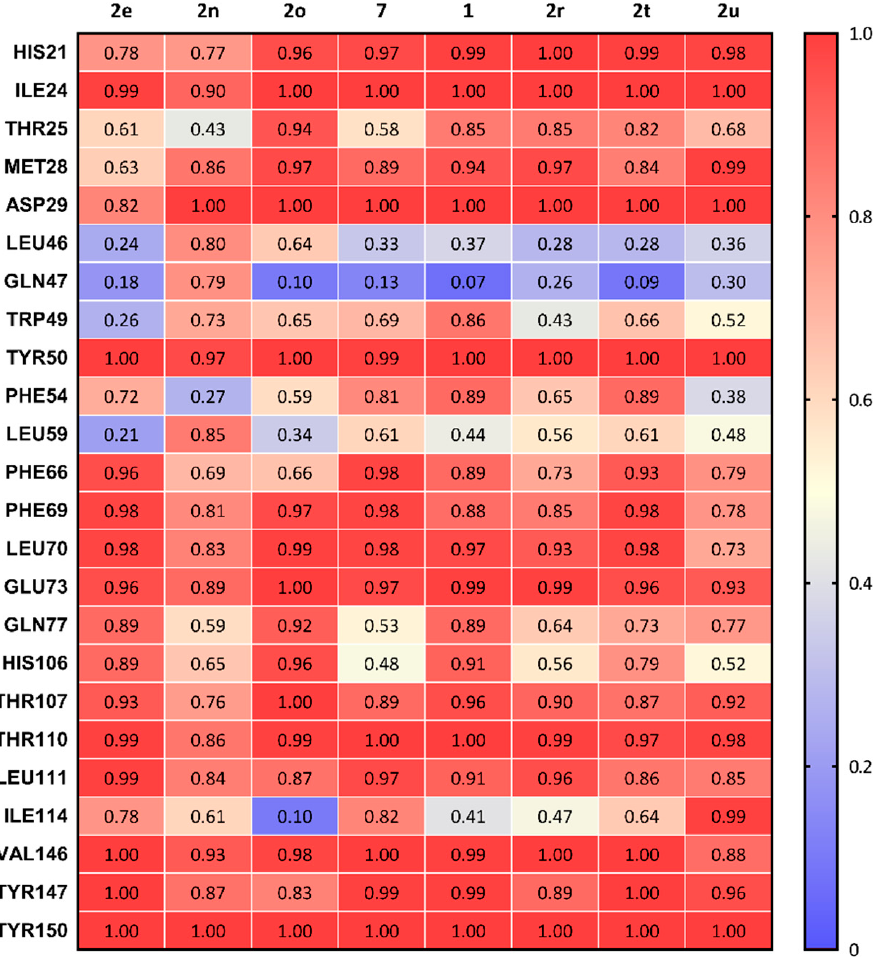
Figure 6. Correlations between σ 2R-binding affinities and ( A ) average of frequency of hydrogen bonds for ASP29 and TYR150 and ( B ) frequency of π interaction of TYR150. 3. Discussion The goal of this study was to determine the effect of replacing the piperazine moiety of compound 1 with different isosteres, such as spirocyclic and bridged diamine ring sys- tems. Our group previously used this strategy to synthesize compounds targeting either the dopamine D3 receptor or the DNA repair enzyme PARP-1 [29,30]. We were somewhat surprised to see that this substitution generally led to a reduction in affinity for σ 2R and an increase in affinity for σ 1R. The most potent compound in this series was the homopi- perazine analog 2t , which had an affinity of 4 nM for σ 2R and modest selectivity versus σ 1R. Another compound displaying good affinity for σ 2R and modest selectivity versus σ 1R was the bridged analog, 2r . Although the SAR studies did not lead to high-affinity σ 2R-selective compounds, the range of binding affinities in the compounds reported here provided a good opportunity to conduct molecular modeling studies to evaluate the properties important for interact- ing with this protein. Our results indicate that hydrogen bond interactions with ASP29 and π stacking interactions with TYR150 are the primary drivers of high affinity for σ 2R. These results are currently being used in docking and MDS studies to identify new scaf- folds having a high affinity for σ 2R. 4. Materials and Methods 4.1. Chemistry All reagents and solvents for synthesis were purchased and used without further pu- rification. Structures of synthesized chemicals were identified using 1 H and 13 C nuclear